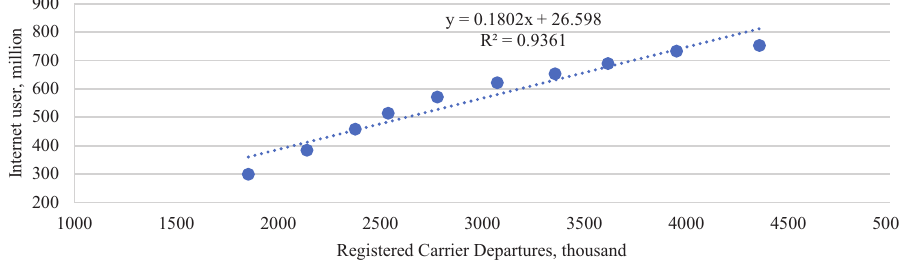
Figure 9. Regression result of registered carrier departures in China from 2008 to 2017